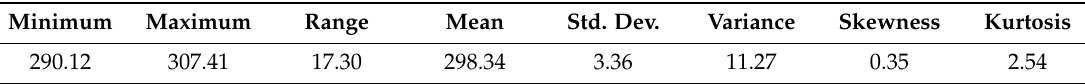
Table A5. Statistics of the averaged air outlet temperature distribution